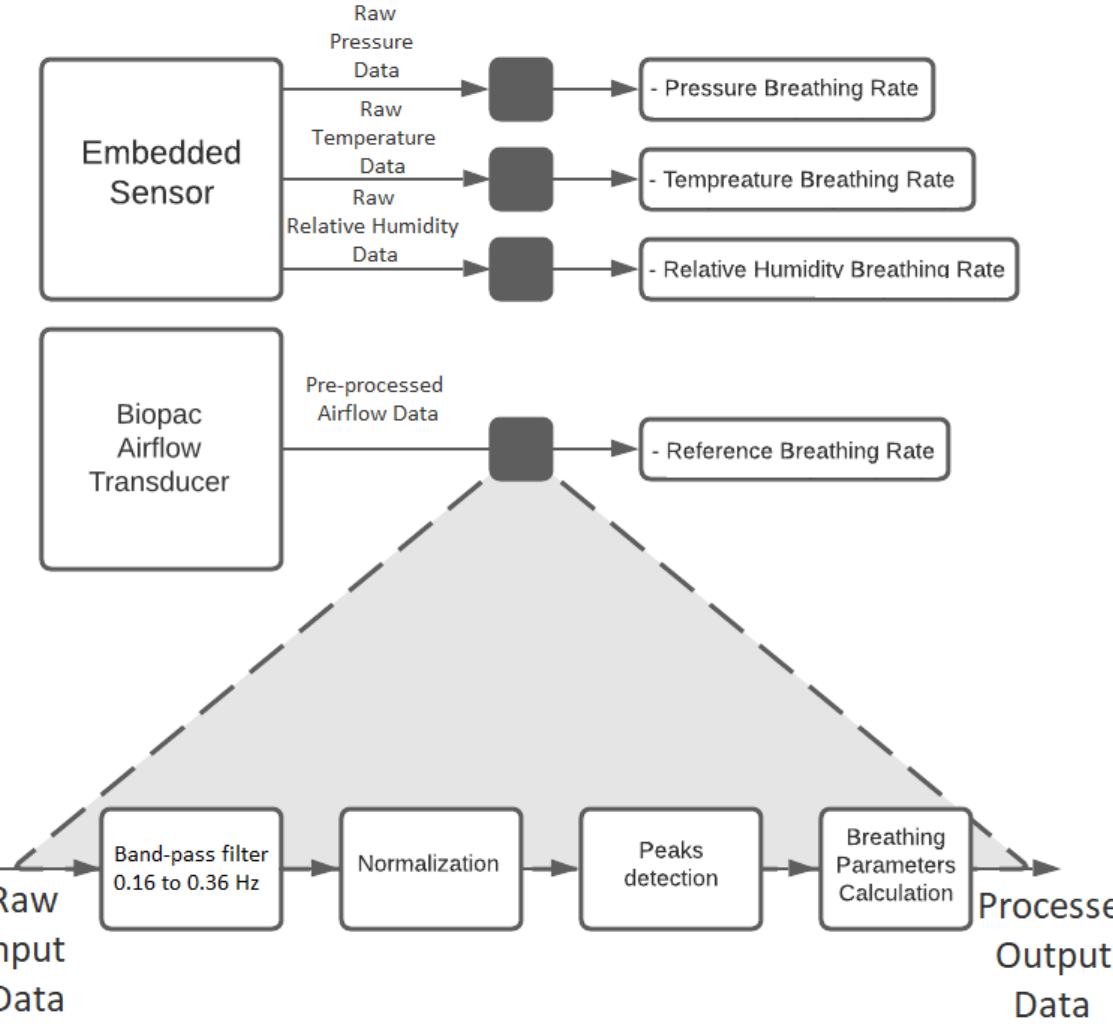
Figure 9. Signal processing